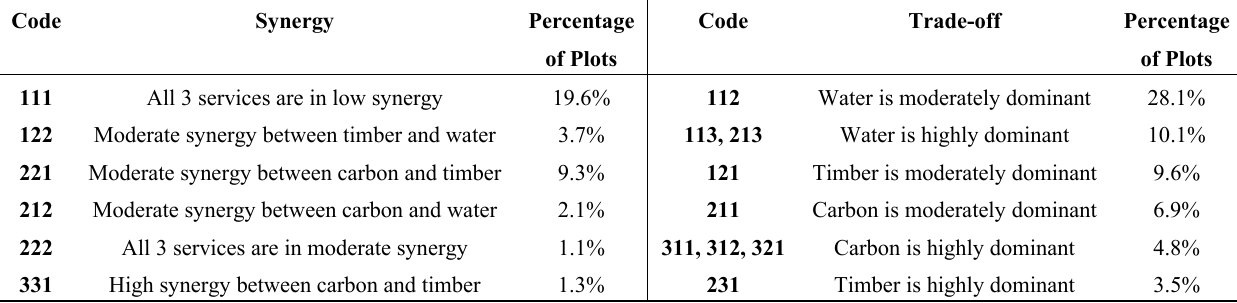
Table 1. Percentage of plots in each category of interactions among carbon sequestration, timber volume and water yield. The order, or sequence, of the three digits in the Code field is always carbon sequestration as the first digit, timber the second digit, and water yield as the